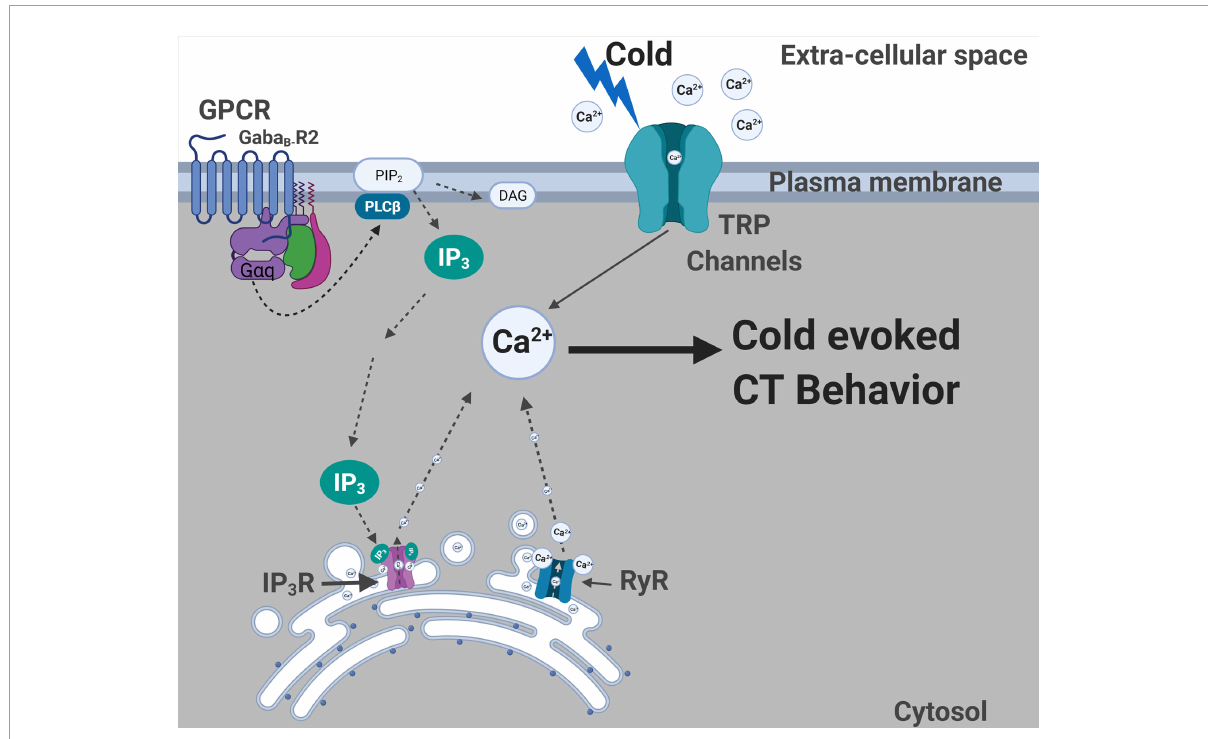
FIGURE8 Summary of molecules required for cold nociceptive behaviors. Plasma membrane localized TRP channels (Turner et al., 2016) and GPCR (GABA B -R2) are required for cold-evoked behaviors. G α q and Plc signaling is also required for cold nociception. ER localized IP 3 R and RyR channels are required for cold-evoked CT response. GABA B -R2, IP 3 R, and RyR are all required for cold-evoked Ca 2 + increases. Created with